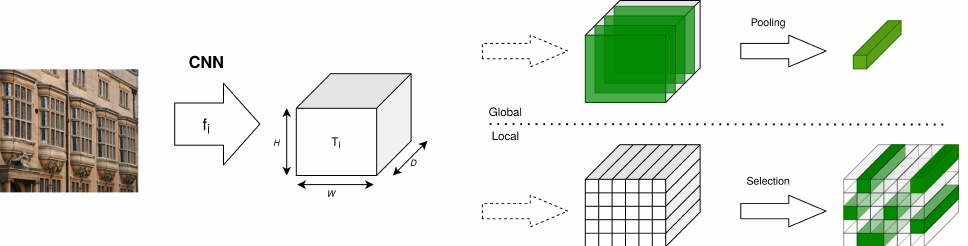
Figure 5. Deep descriptor extraction principle. The tensor Ti of activations can be seen as a C- dimensional stack of activation maps that can be reduced to a single C-dimensional global vector, or as an array of C-dimensional local vectors that must be filtered to keep the N most discriminative local